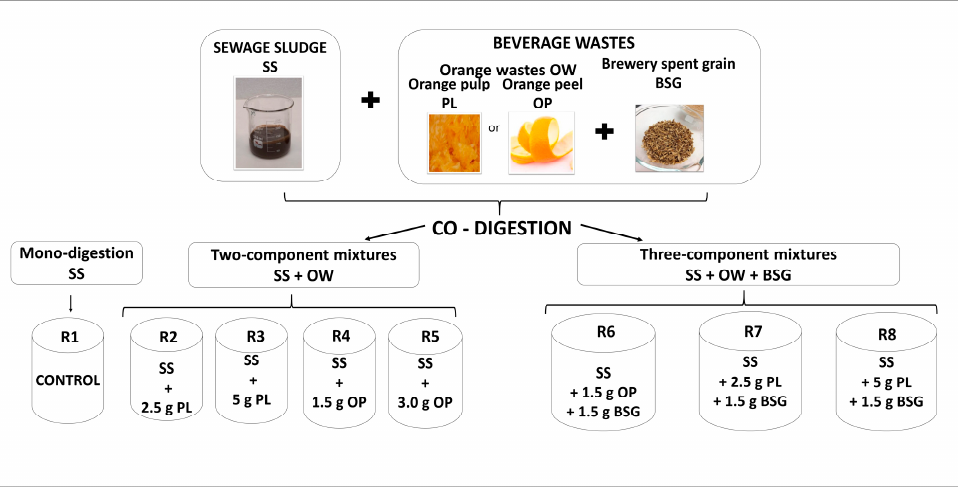
Figure 1. The experimental set-up applied in the present study.